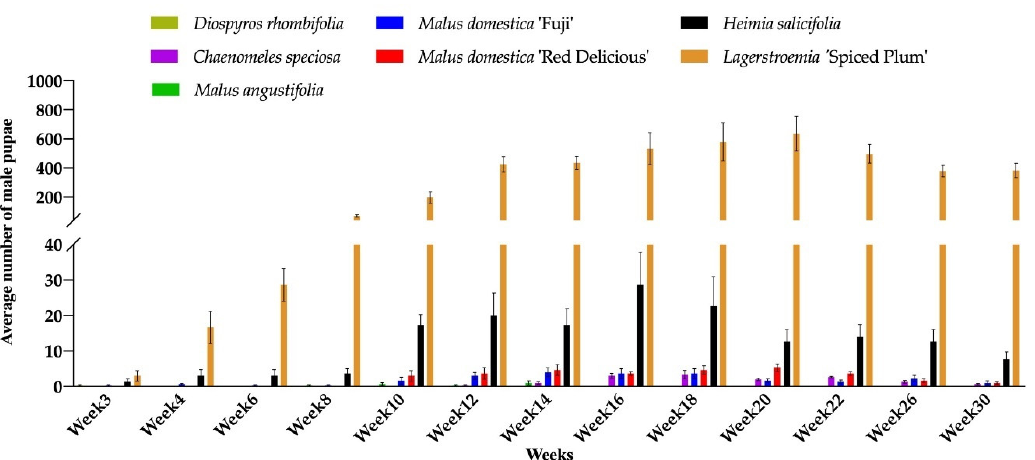
Figure 2. Number of male pupae of Acanthococcus lagerstromiae on Malus domestica ‘Fuji’, M. domestica ‘Red Delicious’, M. angustifolia , Chaenomeles speciosa , Diospyros rhombifolia , Heimia salicifolia , and Lagerstroemia ‘Spiced Plum’, recorded from June to December 2019.